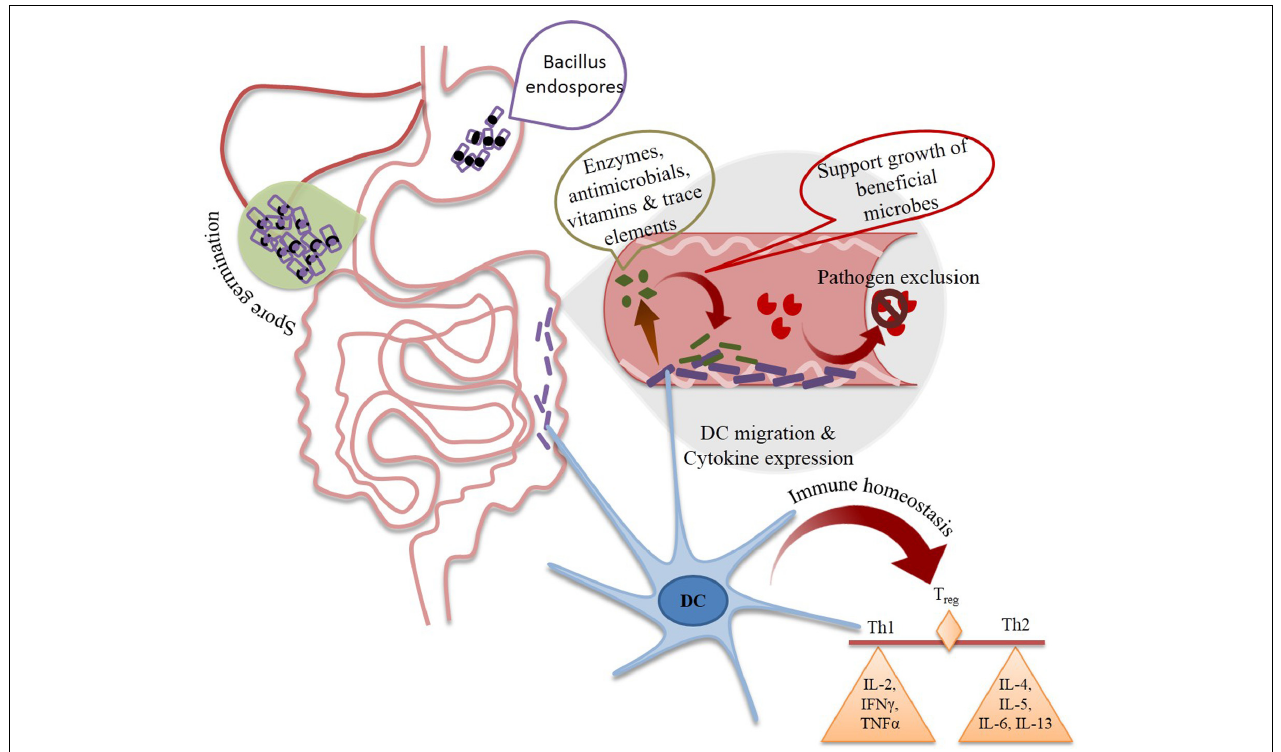
FIGURE 4 | Different possible mechanisms of health benefits of spore forming Bacillus probiotics (SFBP). Daily intake of SFBP is resulted in increased their colonization in gut resulting in increased number of beneficial microbial population and decreased number of pathogenic strains. Moreover, SFBP could proliferate different immune cell for production of anti-inflammatory cytokines to maintain immune homeostasis. DC, Dendritic cells, T reg , regulatory T cells, Th, T helper cell, IL, interleukin, IFN γ , interferon γ , TNF α , tumor necrosis factor α